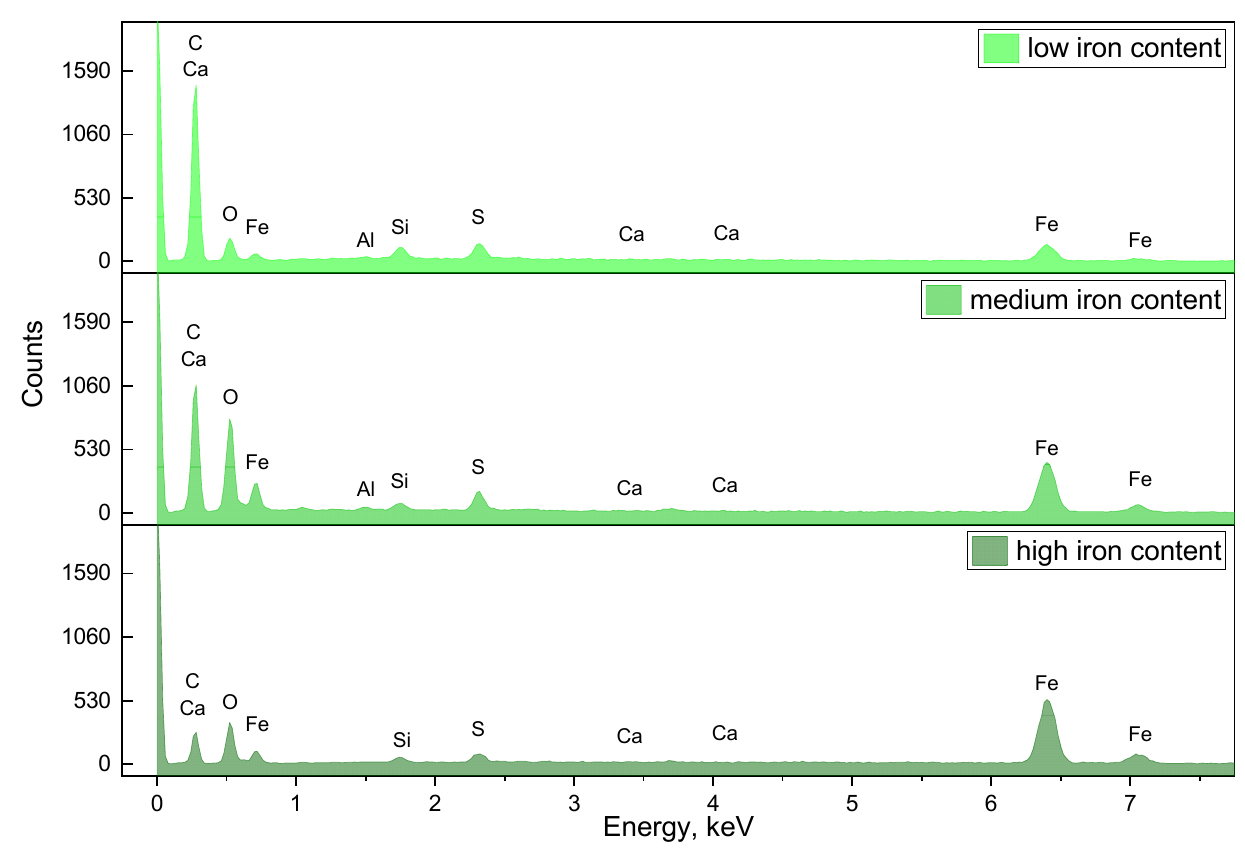
Figure 1. The EDX spectra for the points with low, medium and high iron content.